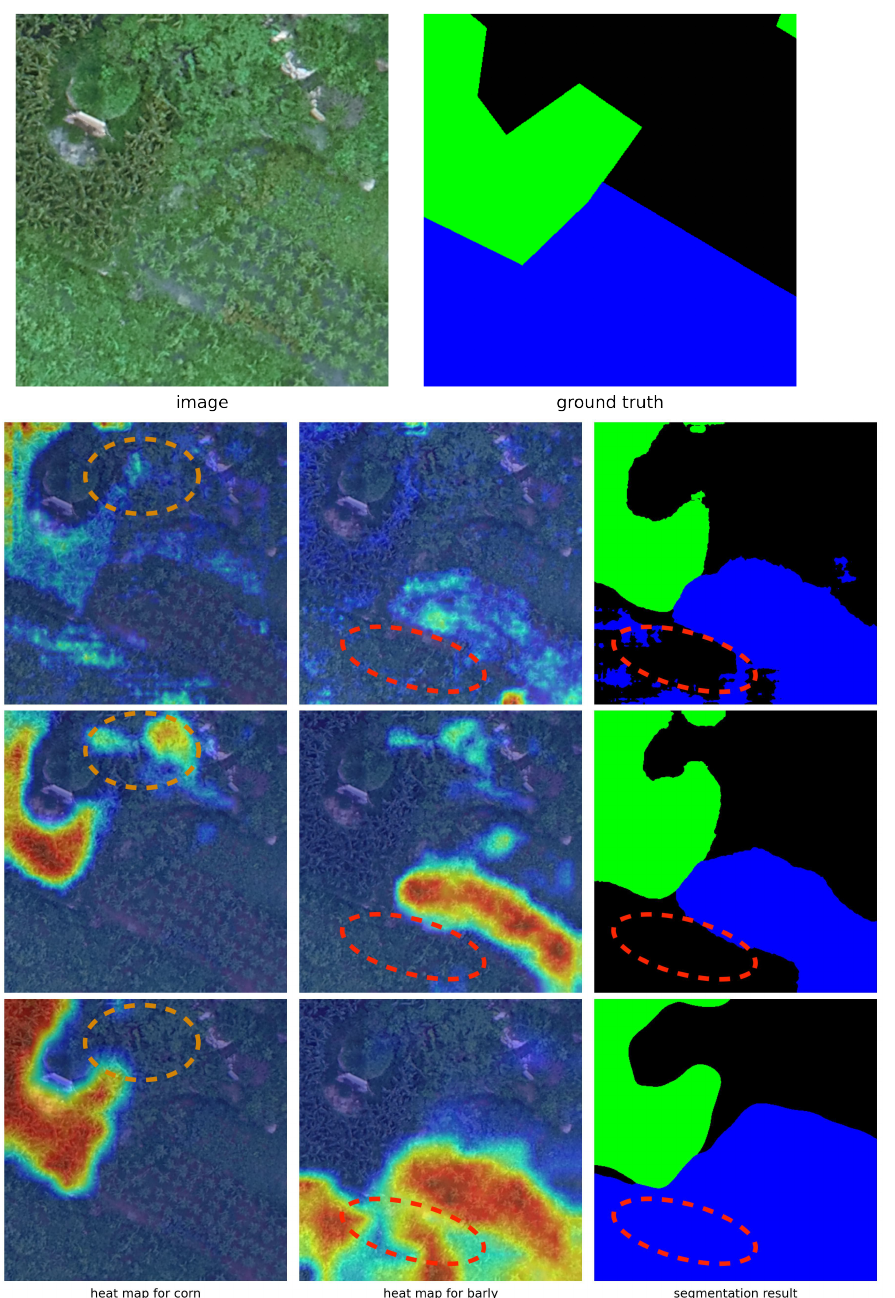
Figure 9. An example of heat map of corn and barley. The rows from top to bottom are results from DeepLabV3+, SegFormer and the proposed CTFuseNet,